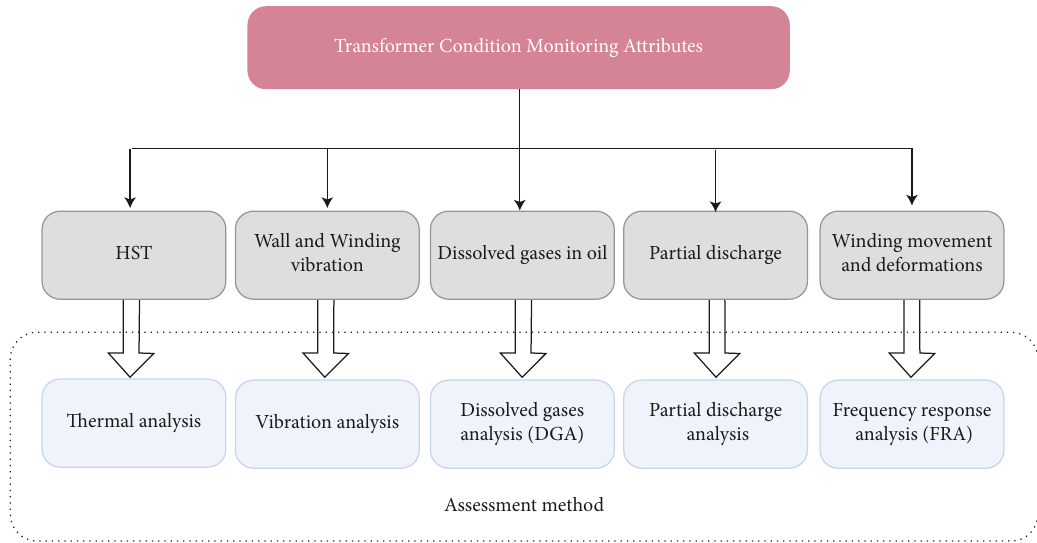
Figure 5: Typical transformer condition valuation